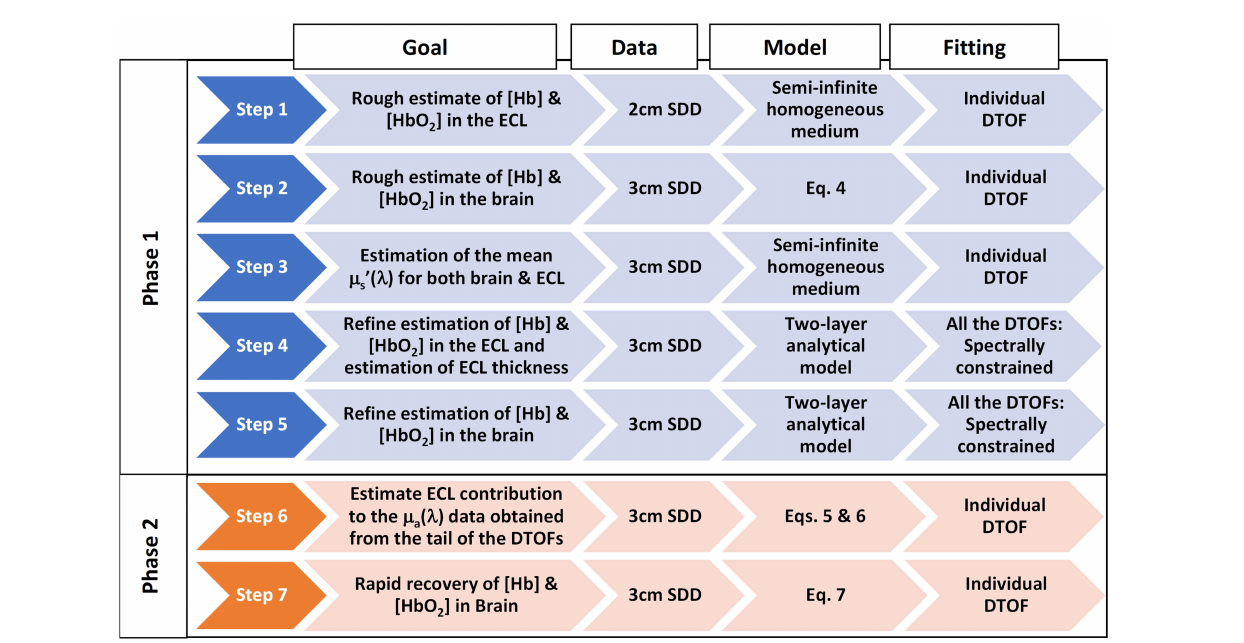
( λ ), and ECL (T, λ ), can be rapidly Brain